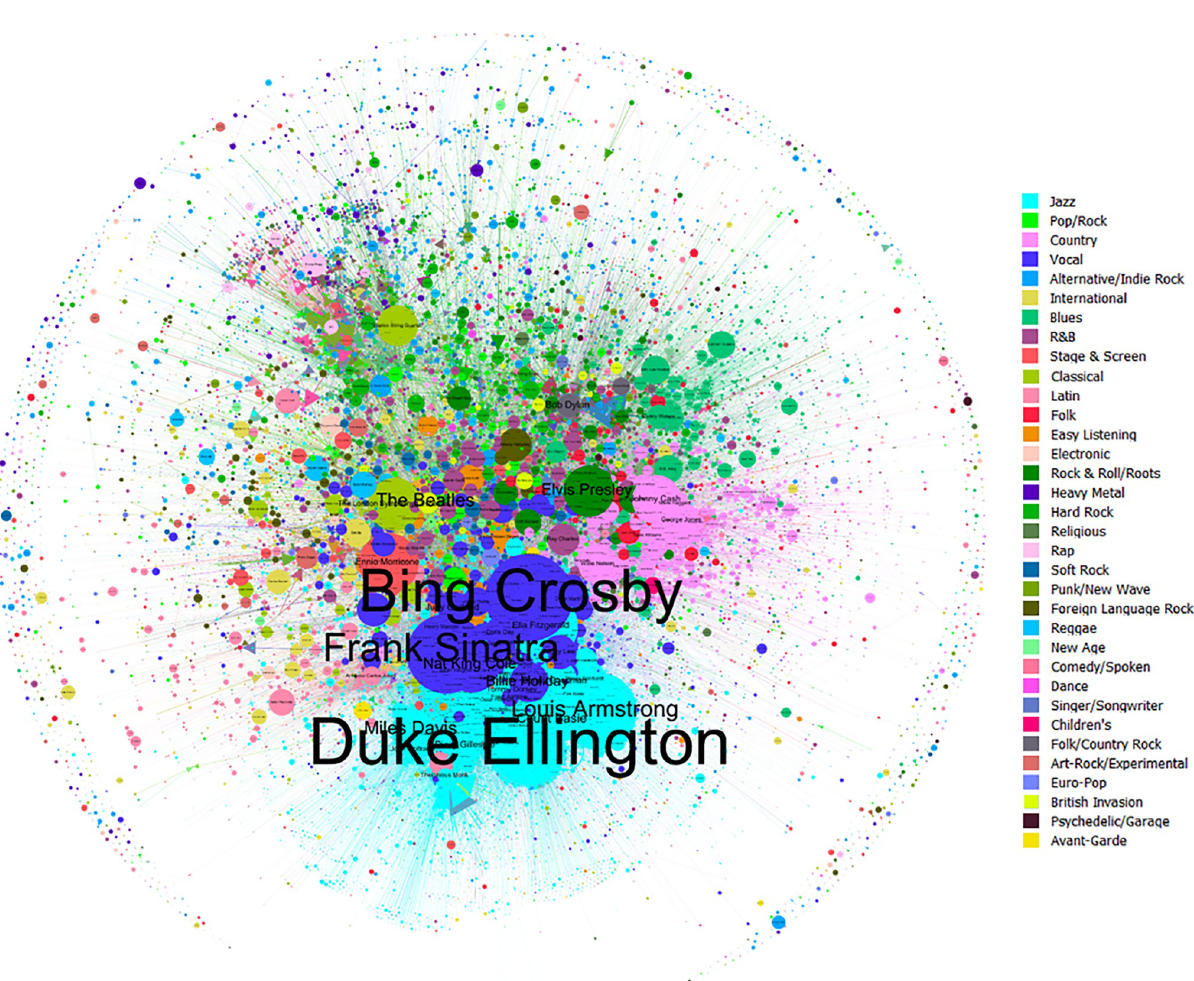
Fig 6. Directed network graph of artists (N = 106,095) linked through covers (N = 855,650), coloured according to music genre, with node size according to number of recorded songs (Layout = Fruchterman Reingold).